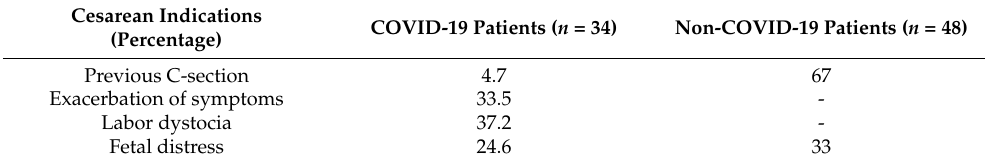
Table 2. Cesarean section